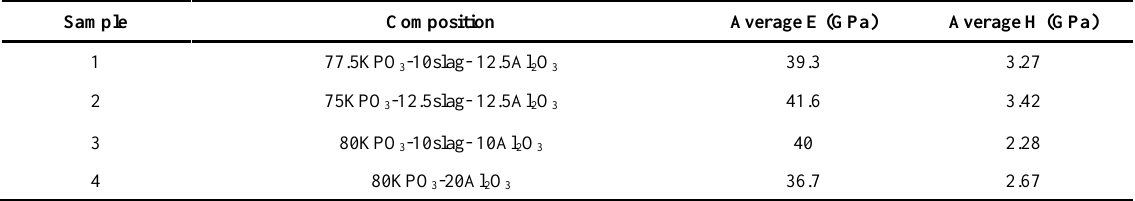
Table 4: Average elastic modulus and hardness of Series 1 determined by nanoindentation.